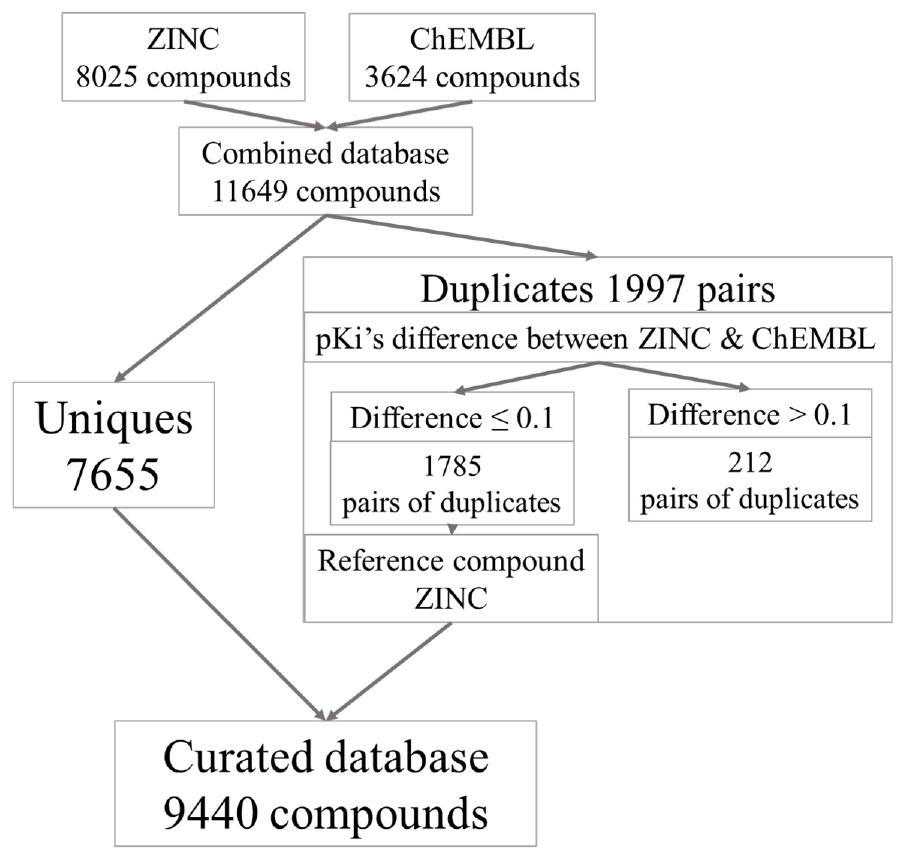
Figure 2. Creation of the curated database of 5-HT1A receptor ligands.